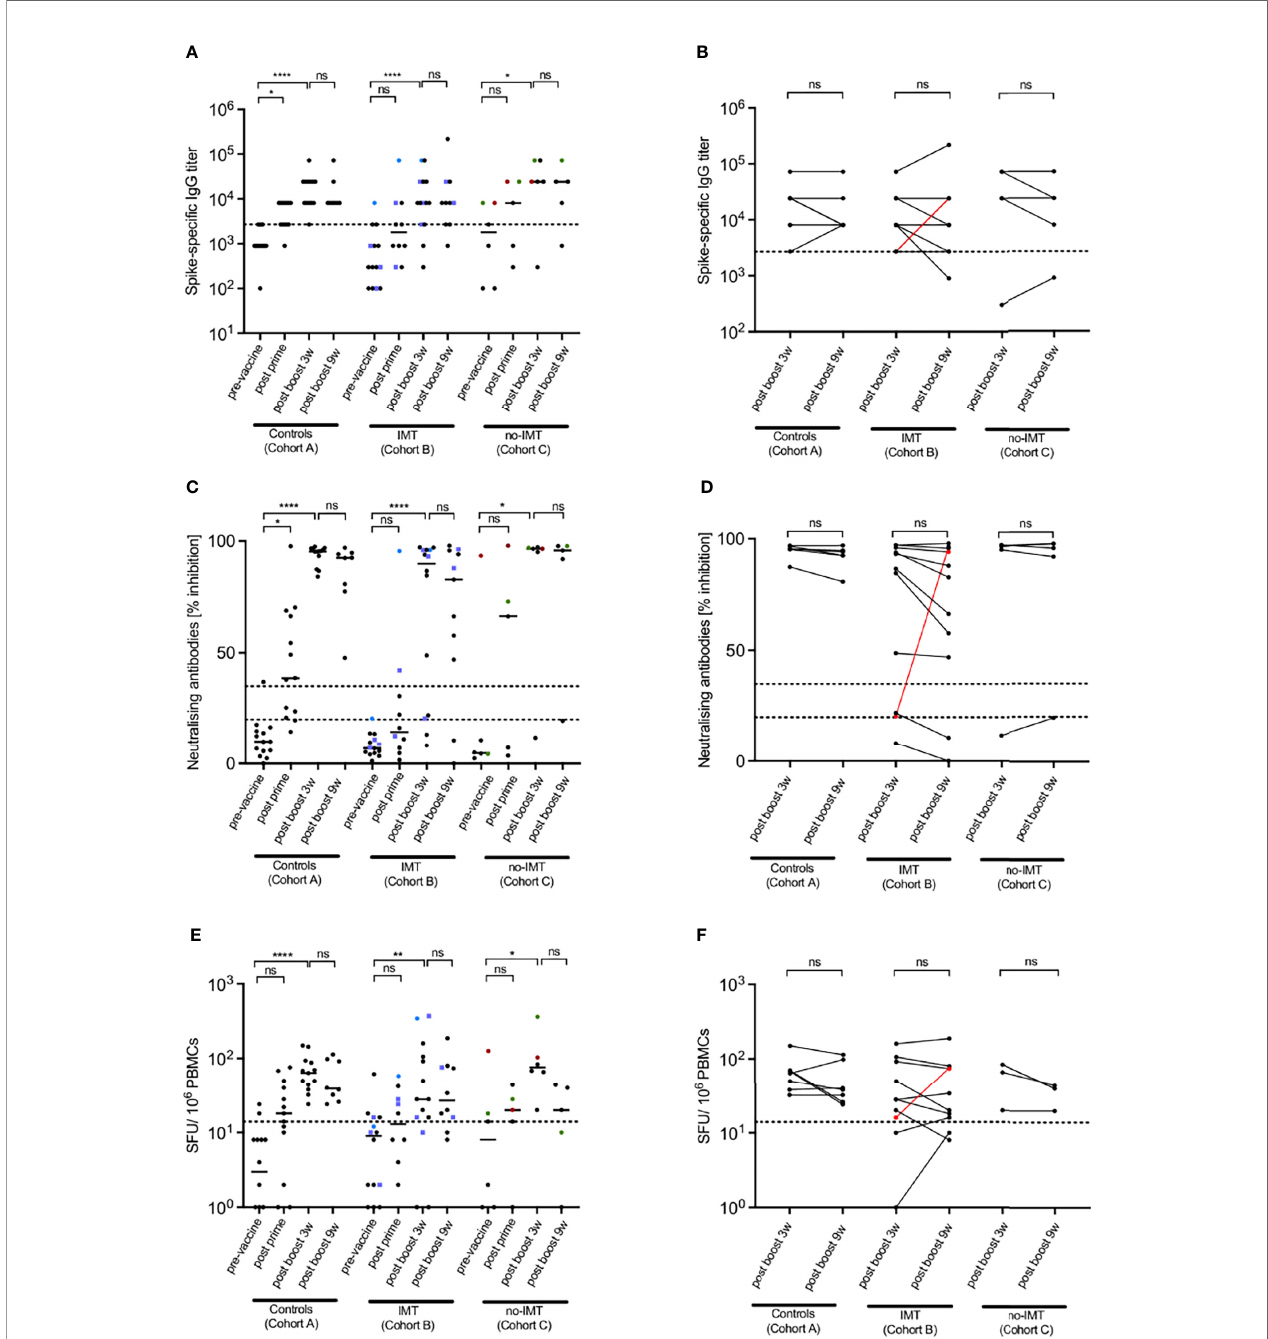
FIGURE 1 | SARS-CoV-2-speci fi c immune responses after COVID-19 vaccination. Spike-speci fi c IgG titers (A, B) , nAb titers (C, D) and spike-speci fi c T cell responses (E, F) in healthy donors (Cohort A), CP under immunotherapy (anti-PD1/PD-L1) (IMT; Cohort B, subgroups B.1 and B.2) and CP not treated with immunotherapy (no-IMT; Cohort C) after two doses of mRNA-based COVID-19 vaccines. Individuals from subgroups B.1 are represented by circles and individuals from subgroup B.2 are represented by blue squares. Dotted lines indicate positive thresholds for Spike-speci fi c IgG and T cells. In case of nAbs (C, D) , the dotted line determines the thresholds for negative, intermediate, and positive results according to manufacturer ’ s instructions. Patients with a supposedly previous asymptomatic SARS-CoV-2 infection are differently coloured (red circled symbols for CP19; blue circled symbols for CP7 and green circled symbols for CP16) and excluded from statistical analyses. Bars represent medians. Differences between the groups were calculated using Mann – Whitney test or Kruskal-Wallis test for comparison of two or three groups. Non-signi fi cant differences were indicated as “ ns ” . P-values below 0.05 were considered signi fi cant and wereindicated by asterisks: *p < 0.05; **p < 0.01; ***p < 0.001; ****p <